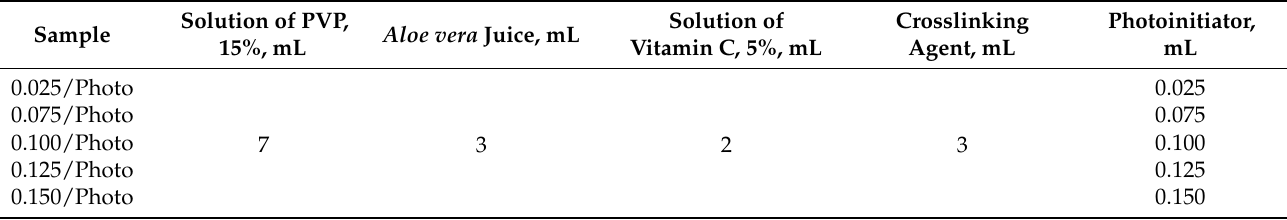
Table 1. Detailed compositions of hydrogel